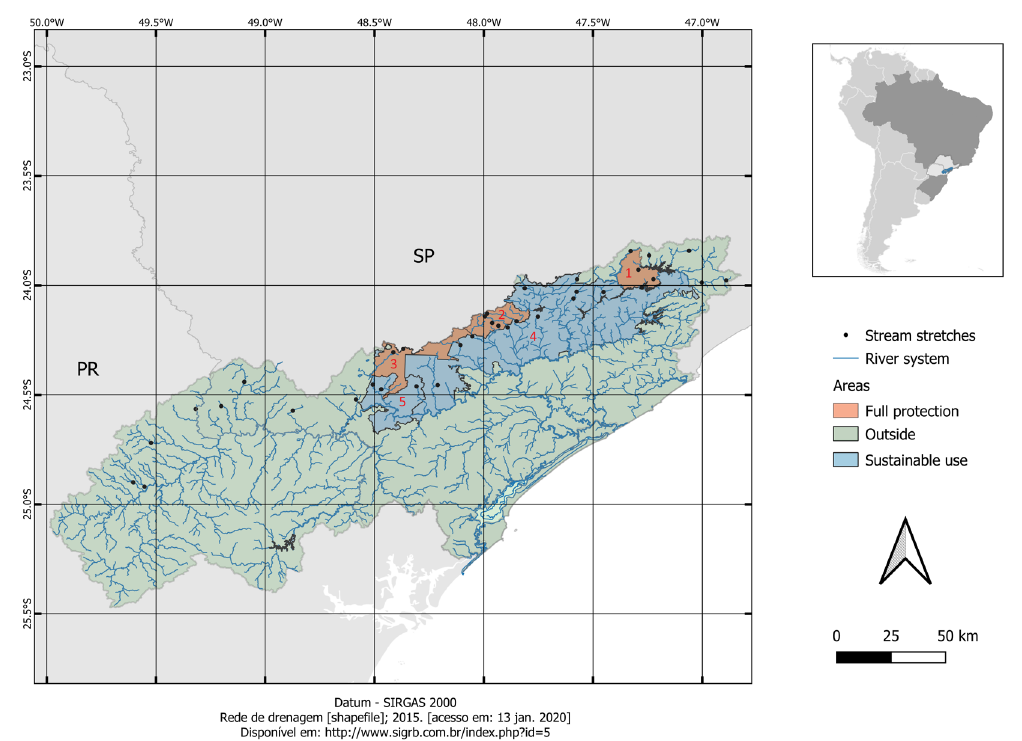
FIGURE 1 | Protected Areas and stream stretches sampled in the rio Ribeira de Iguape basin. 1) Parque Estadual Jurupará (PEJU), 2) Parque Estadual Carlos Botelho (PECB), 3) Parque Estadual Intervales (PEI), 4) Área de Proteção Ambiental da Serra do Mar (APASM), and 5) Área de Proteção Ambiental Quilombos do Médio Ribeira